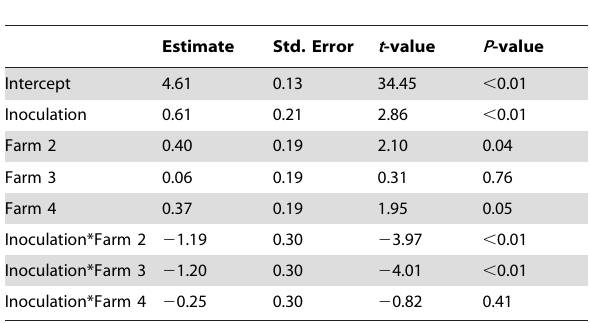
Table 1. Linear model testing effect of inoculation and farm on shoot biomass of Triticum aestivum in the conditioning